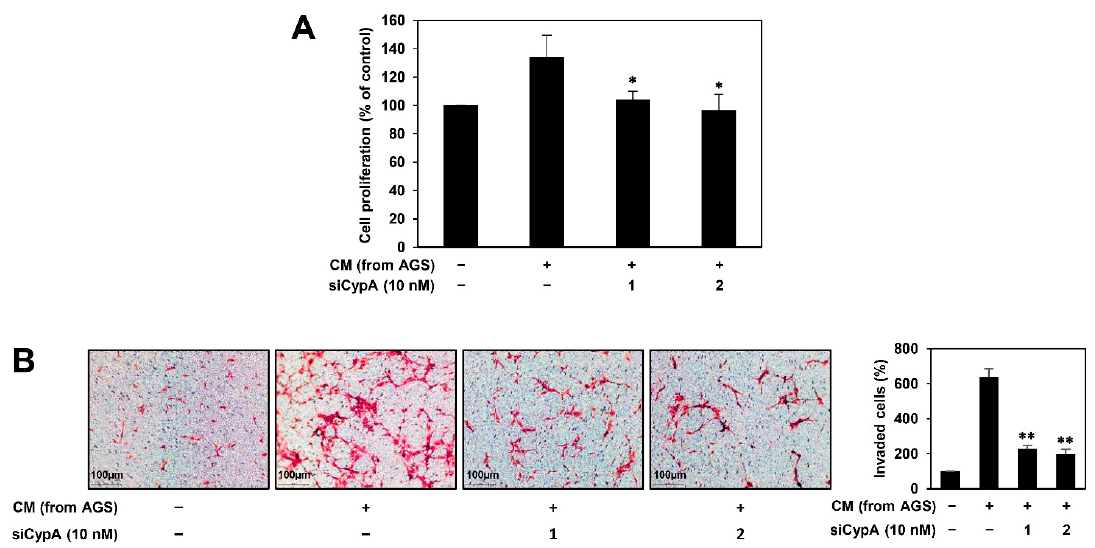
Figure 8. Effect of CypA knockdown on the AGS cell-induced angiogenesis of HUVECs. AGS cells were transfected with CypA siRNAs (10 nM) and incubated for 24 h. CM was obtained from the transfected cells and used for the ( A ) proliferation and ( B ) invasion of HUVECs. * p < 0.05, ** p < 0.01 vs. the control.